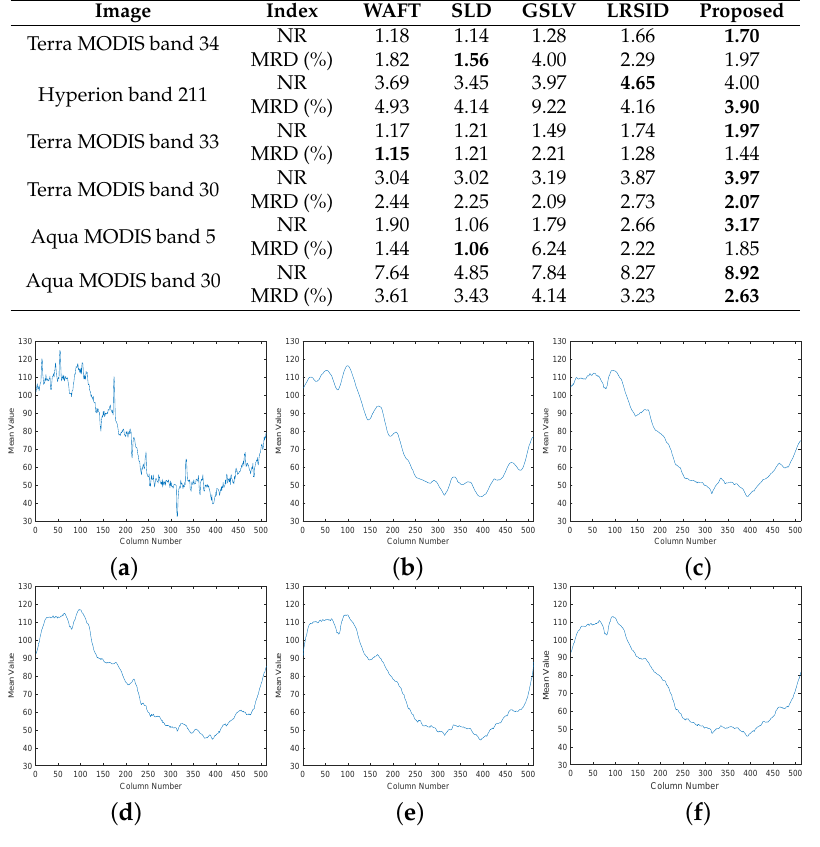
Figure 15. Mean cross-track profiles of Figure 8. ( a ) Original image; ( b ) WAFT; ( c ) SLD; ( d ) GSLV; ( e ) LRSID; ( f ) the proposed method.